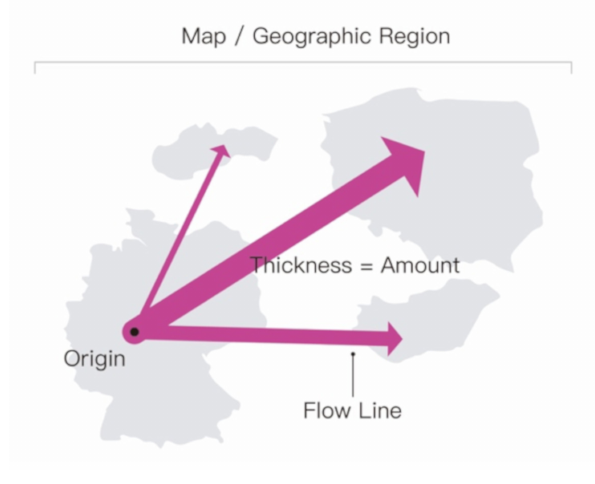
Figure 1. A flow